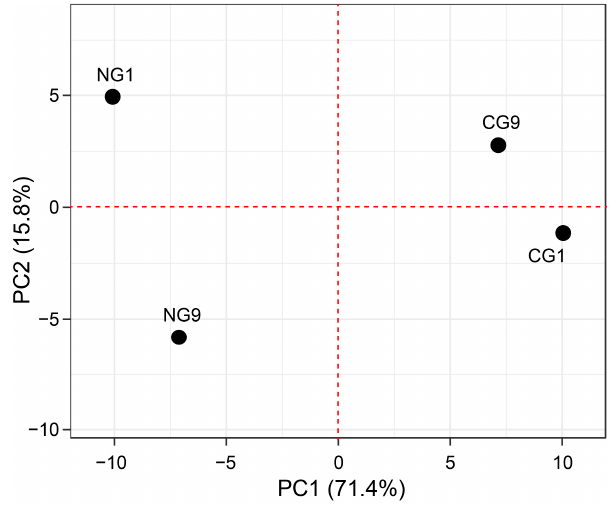
Figure 3. Principal component analysis (PCA) for metabolites of G9 and G1 under low nitrogen (N) and control (C) conditions.